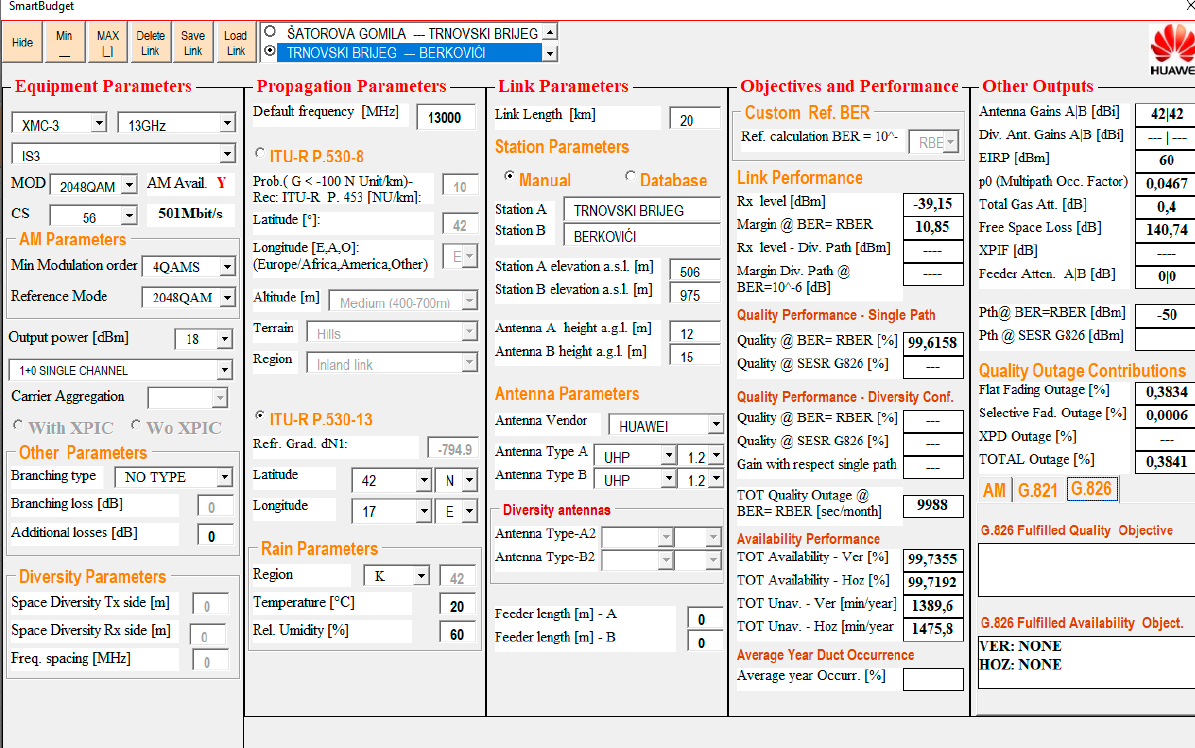
Figure 7. Prediction for the second RR section; 2048 QAM, 500 Mb/s.